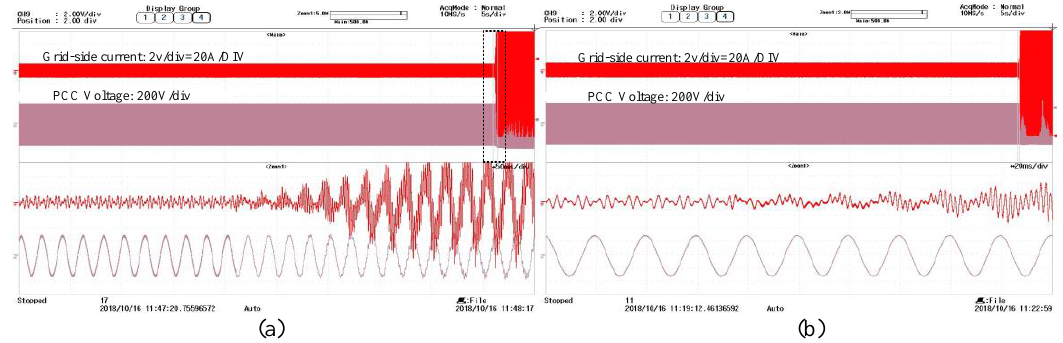
Figure 13. Multi-parallel grid-connected VSI system with adjustable grid impedance.